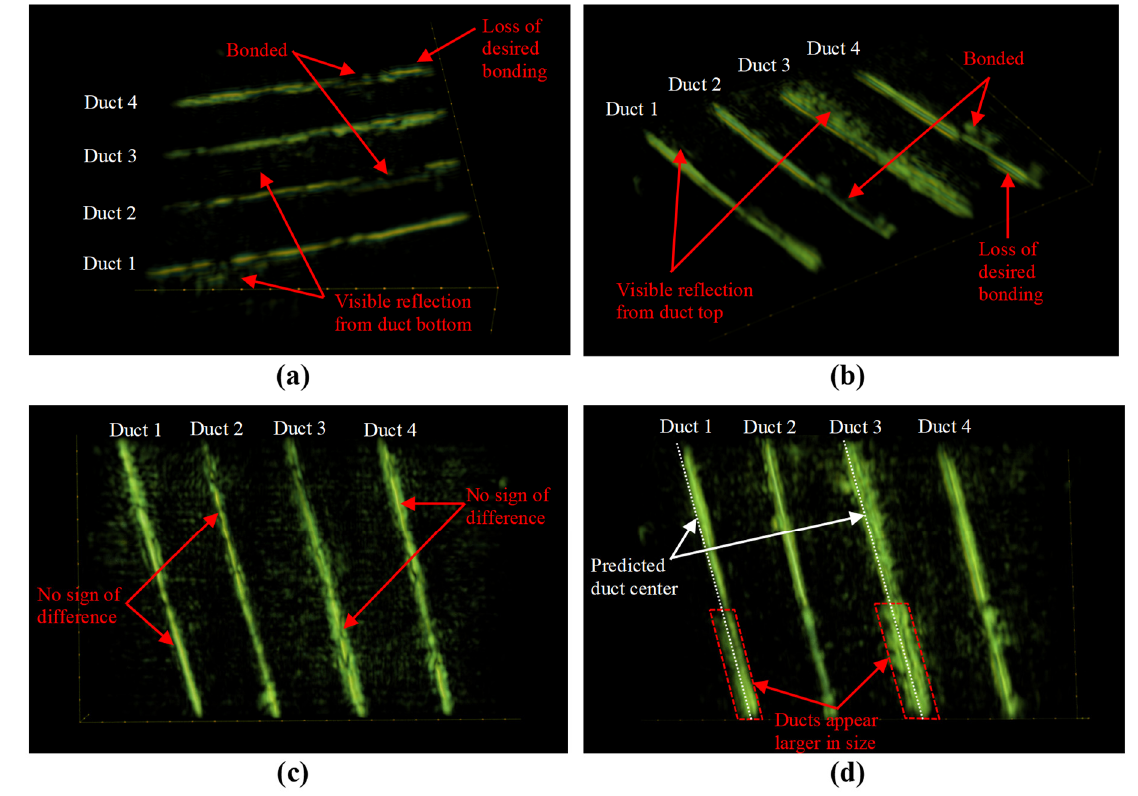
Figure 15. Images for slab 7 from: ( a ) top scan, ( b ) bo tt om scan, ( c ) top scan, ( d ) bo tt om scan.